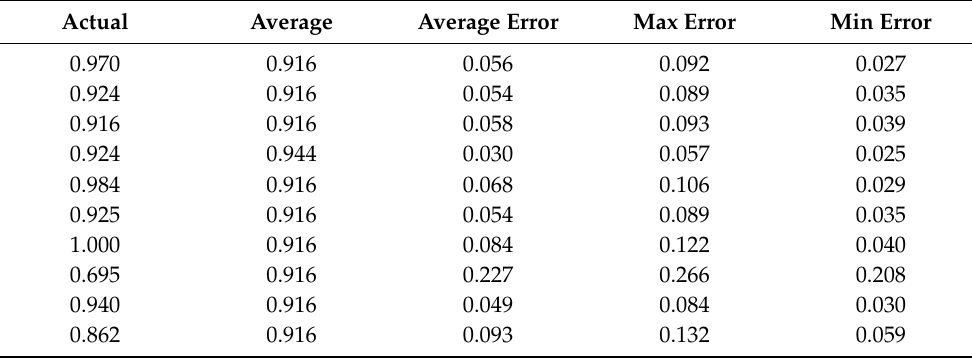
Table A172. Set 3, trials 11–20 data (single 0.5 PR value).